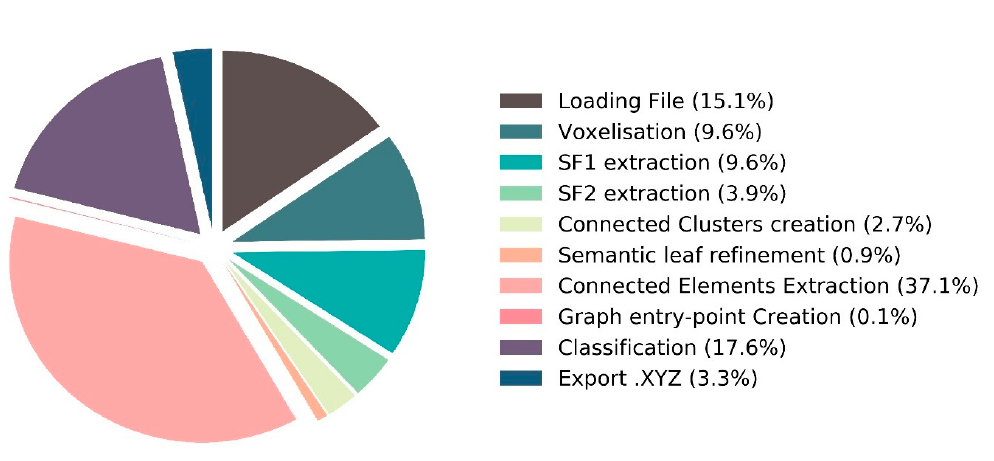
Figure 19. Relative temporal performances of our automatic semantic segmentation Figure 19: Relative temporal performances of our automatic semantic segmentation workflow.